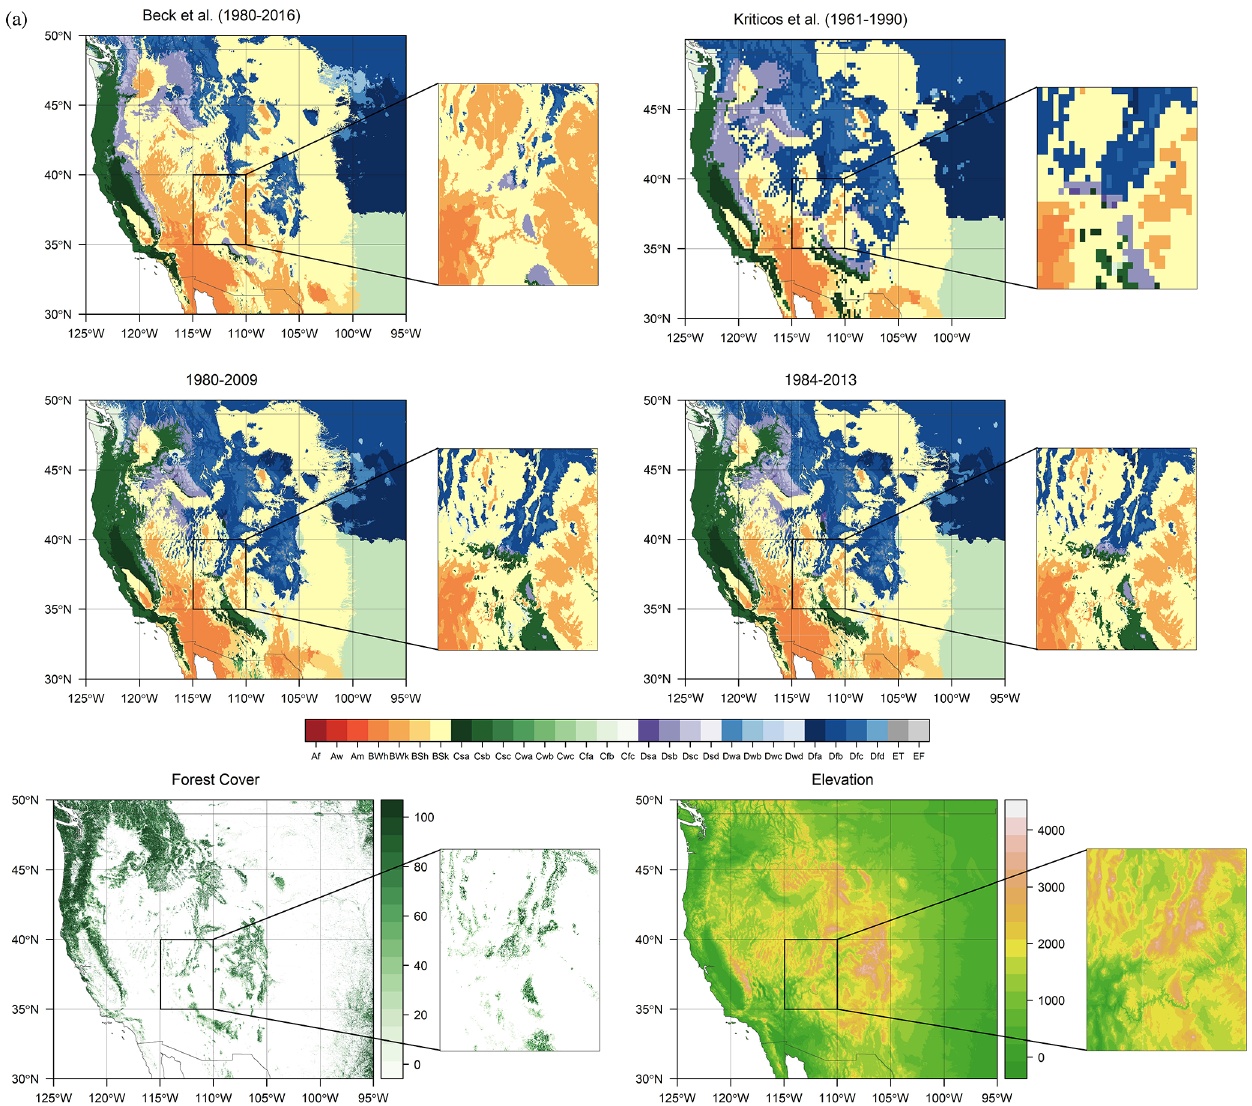
CHELSA and downscaled CRU, GPCC, and UDEL datasets and with only downscaled CRU, GPCC, and UDEL datasets as 82.39 % and 81.17 %, respectively. Using the mean of multiple datasets, which can potentially reduce the data bias, led to better classification results. We estimated the total ac- curacy of the previous high-resolution Köppen–Geiger cli- mate map products using the same validation datasets. We applied the same classification system described in the pre- vious studies and the same time period of the previous cli- mate map product to process the station observation data and estimate their overall accuracy. Compared with the previous high-resolution Köppen–Geiger climate map products, Beck et al. (2018) and Kriticos et al. (2012), the newly